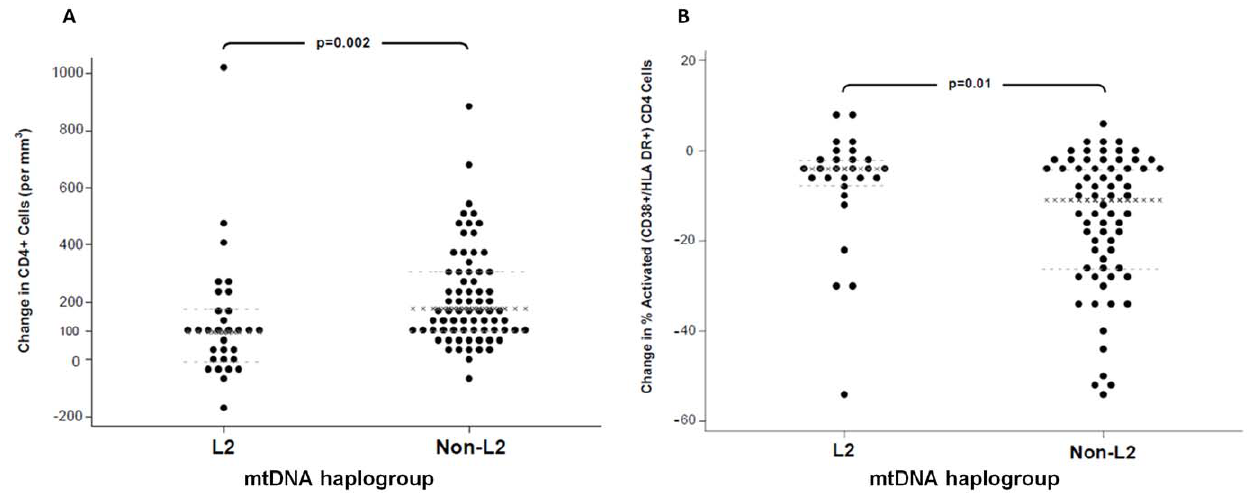
Figure 1. Scatter plots of 48 week changes in CD4 cells (Panel A), and percentage activated (CD38 + /HLA-DR + ) CD4 cells (Panel B). Haplogroup L2 individuals had a significantly lower median increase in CD4 cells and a lower decrease in percentage activated CD4 cells. Unadjusted p-values by Wilcoxon ranksum test shown. x-lines = median; dashed lines=25 th and 75 th percentiles.